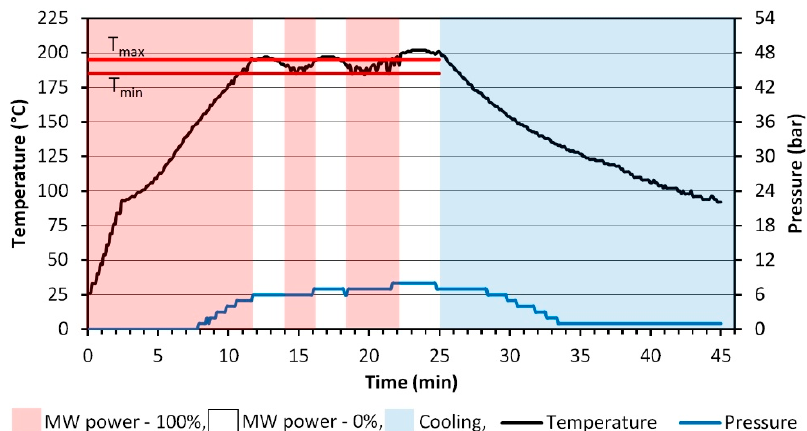
Figure 1. Diagram showing the course of the microwave synthesis of codoped ZnO NPs and undoped ZnO NPs on the example of Zn 0.98 Mn 0.01 Co 0.01 O sample. Experimental data obtained in the microwave reactor Model 02-02.